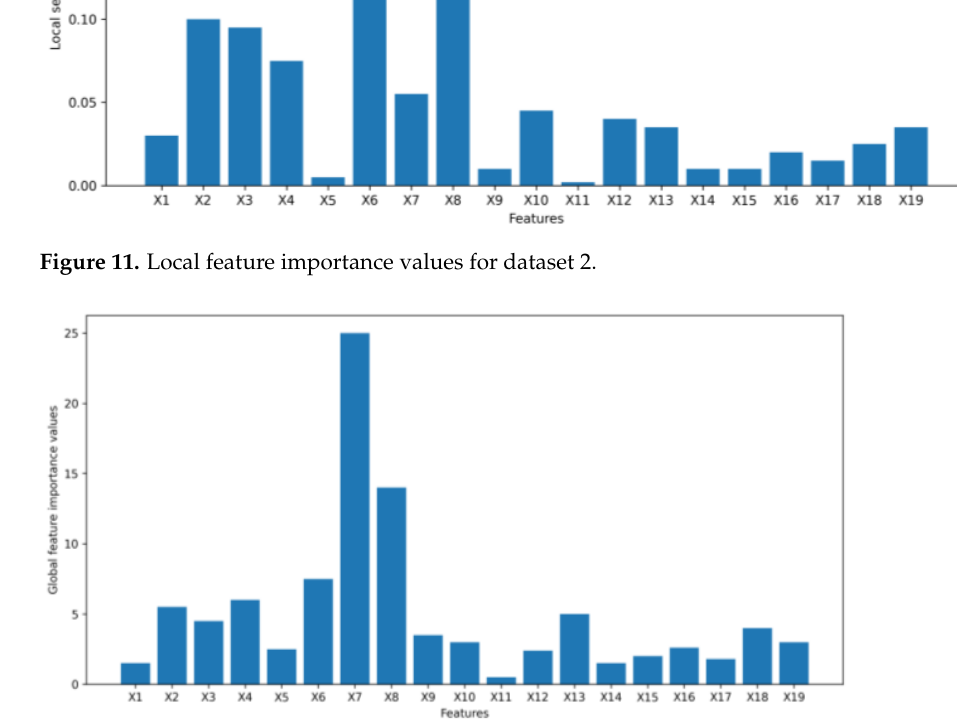
Figure 12. Global feature importance values for dataset 2.